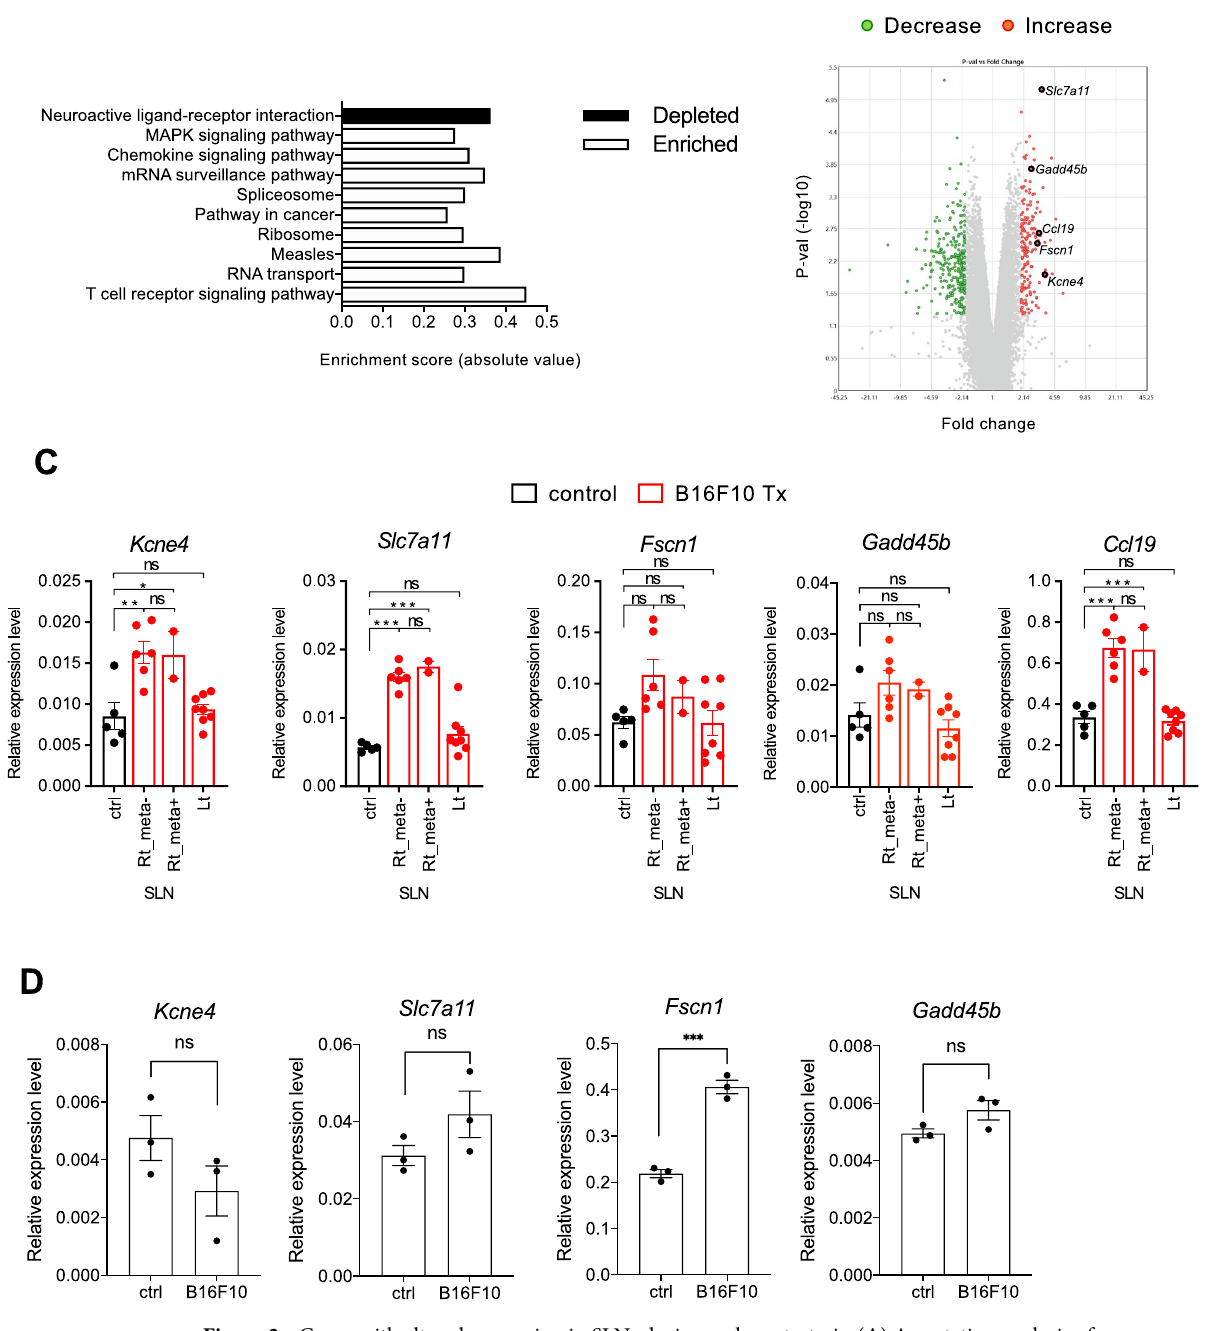
Figure 2. Genes with altered expression in SLNs during early metastasis. ( A ) Annotation analysis of genes whose expression had changed (B16–F10 vs control, fold change of < − 2 and > 2, respectively; p < 0.05). ( B ) Volcano plot of genes with altered expression. ( C ) Verification of Kcne4, Slc7a11, Fscn1 , and Gadd45b expression by qRT-PCR. The expression levels of target genes in SLNs of control mice and SLNs of mice implanted with B16–F10 (right and left) were analyzed. One-way ANOVA, * p < 0.05, ** p < 0.01, *** p < 0.001. ns; not significant. ( D ) LECs were co-cultured with B16–F10 in transwell plates for 24 h, and the expression levels of Kcne4, Slc7a11 , Fscn1 and Gadd45b were analyzed by qRT-PCR. *** p < 0.001. ns; not